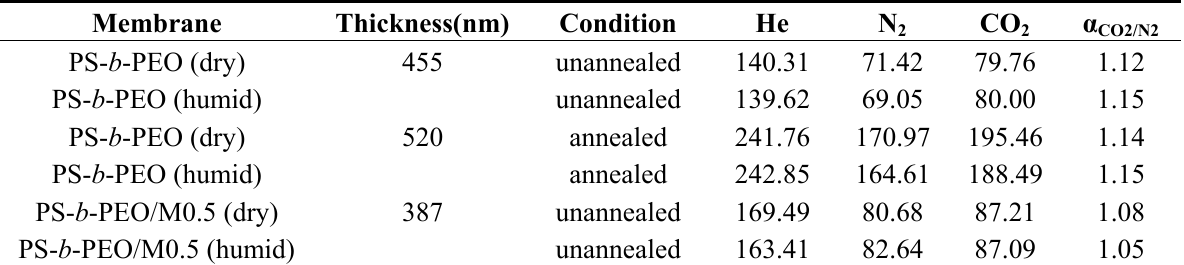
Table 1. Gas permeation of the membrane a